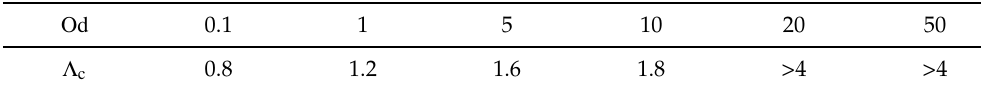
Figure 13. Flow morphology of the polymer gel in rectangular cavities with different aspect ratios at Od = 10 . Table 1. Results for critical aspect ratio Λ c .